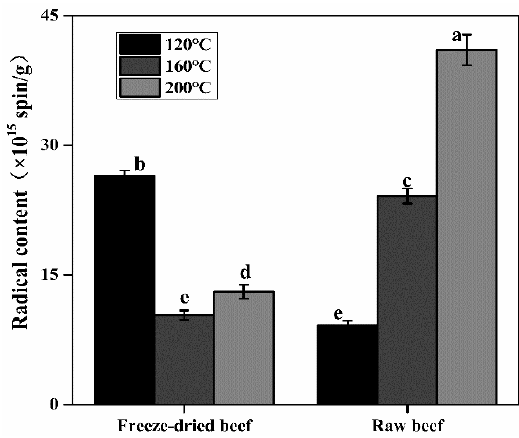
Figure 2. Radical contents of the freeze-dried and raw beefs roasted at different temperatures for 20 min. Means with different letters differ significantly ( p < 0.05).